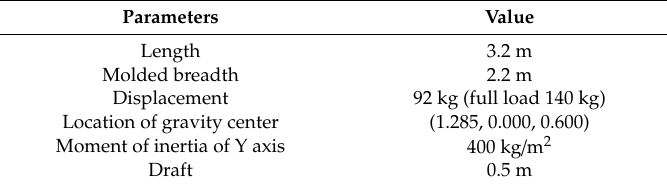
Figure 1. Multi-functional Marine mapping unmanned surface vehicles. Table 1. Table of the unmanned surface vehicle parameters.